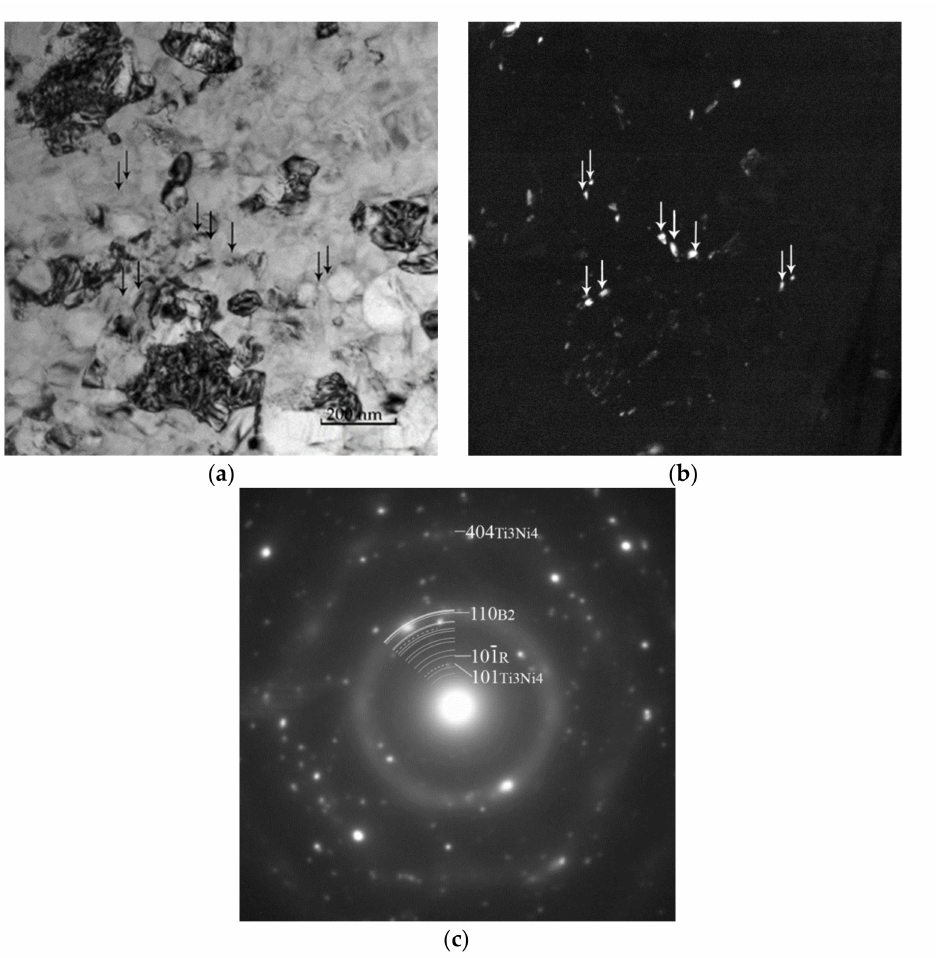
Figure 3. Subgrain structure of Ti-50.9Ni with Ti 3 Ni 4 particles after annealing at 400 ◦ C: ( a ) bright- field images with arrows for particle lines near low-angle boundaries, ( b ) dark field in reflection {101} of Ti 3 Ni 4 particles, ( c ) SAED pattern, solid and dash arcs correspond to positions of reflections of R-and Ti 3 Ni 4